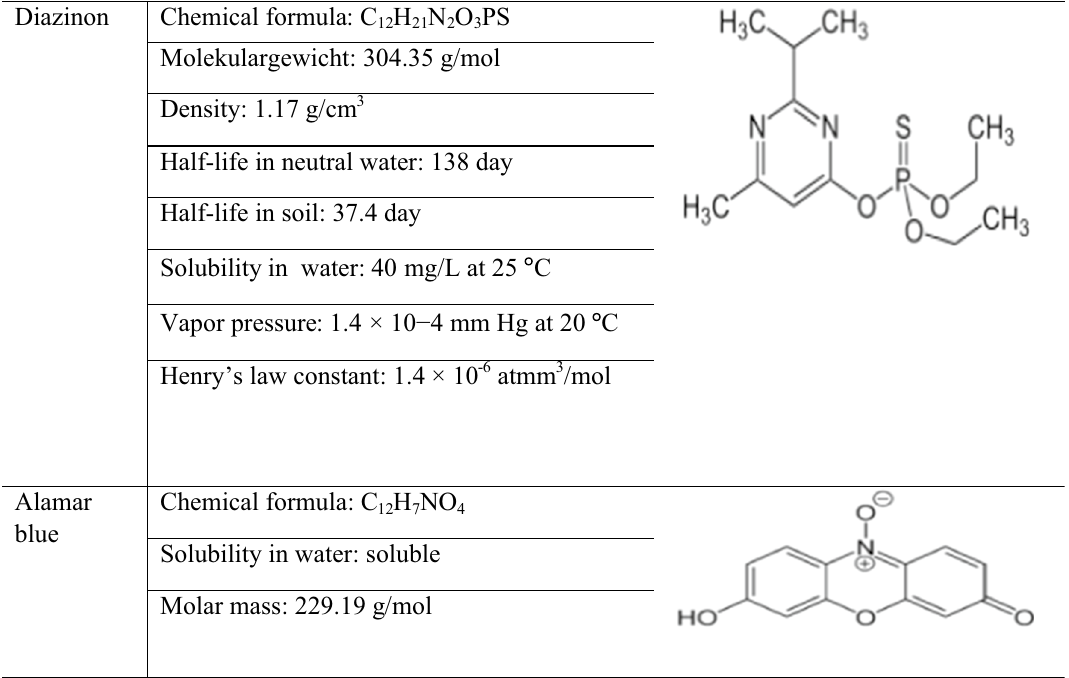
Table 1 Properties of diazinon and alamar blue Diazinon